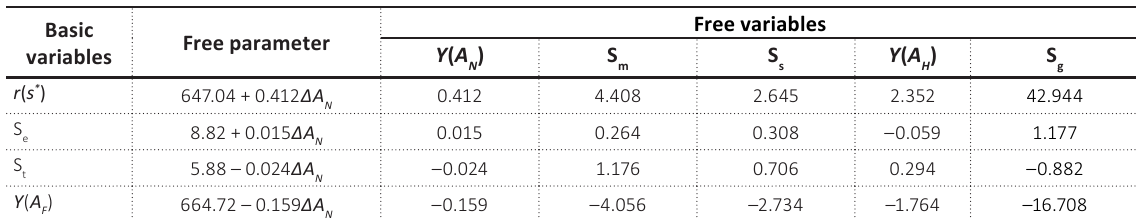
Table 5. Analysis of changes in the limitations of natural assets of “wow-effect” tourism on the final iteration of